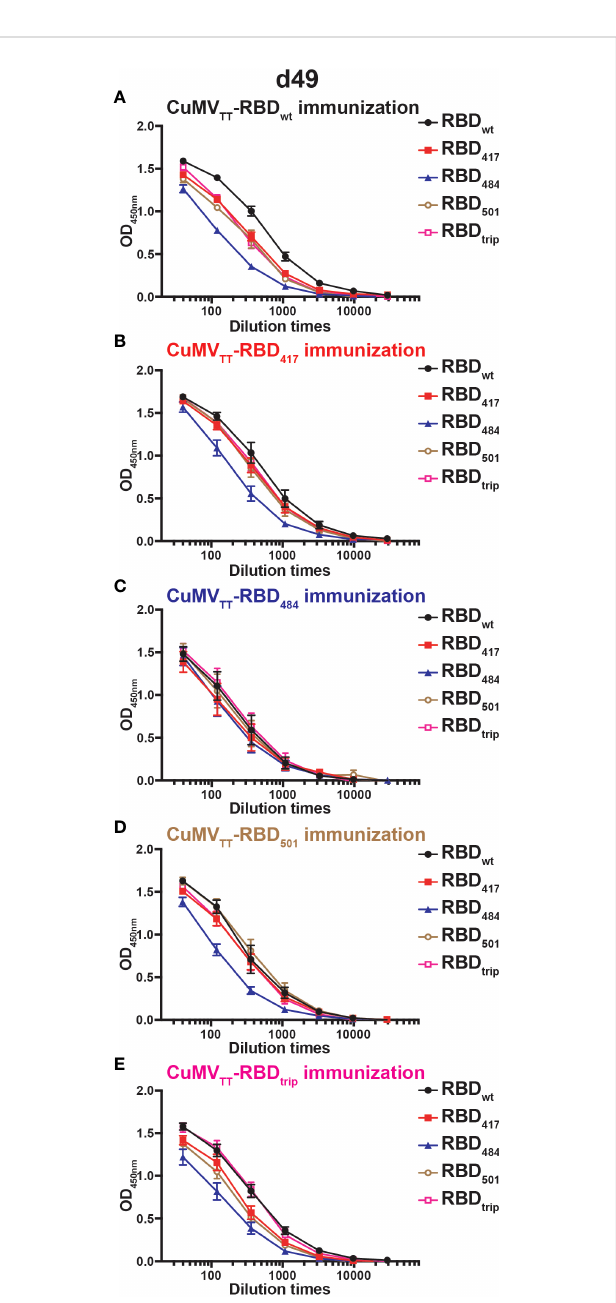
FIGURE 4 IgA antibody responses of mice sera on d49 immunized with CuMV TT - RBD wt (A) , CuMV TT -RBD 417 (B) , CuMV TT -RBD 484 (C) , CuMV TT -RBD 501 (D) , or CuMV (E) . ELISA curves of OD values with serum TT -RBD trip dilution were